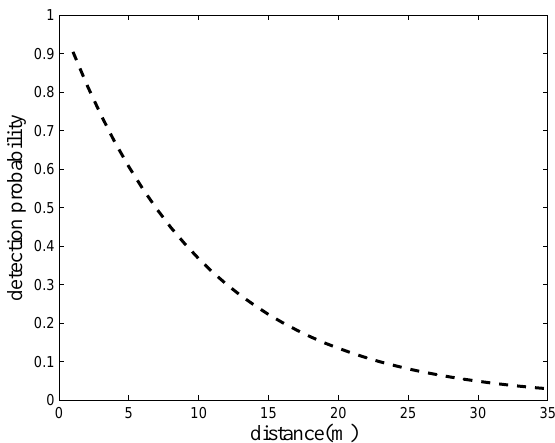
Figure 1. Change in detection probability with distance (m), where α = 0.1.